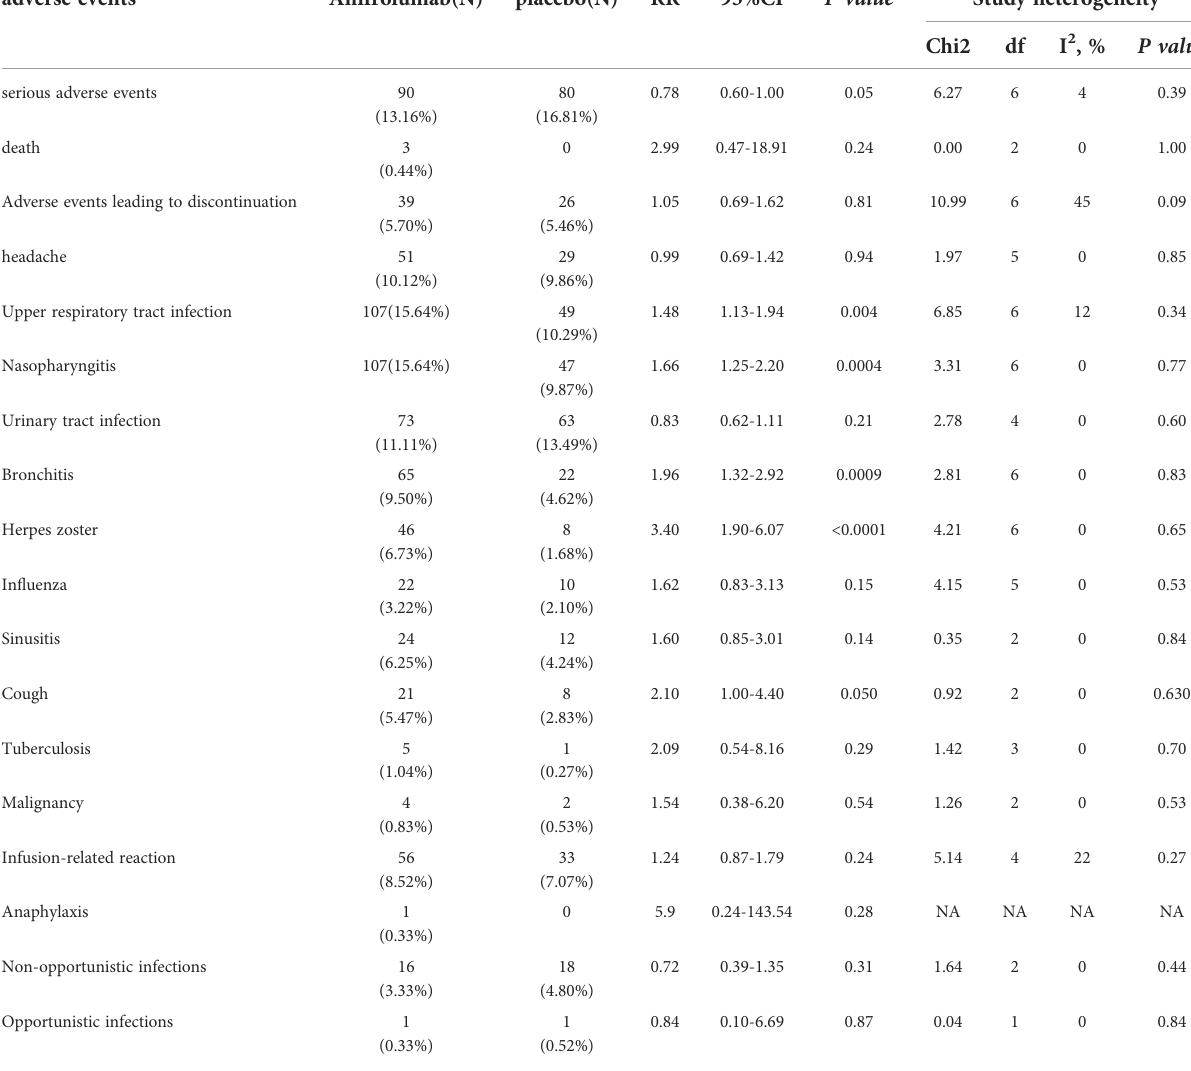
TABLE 2 Adverse